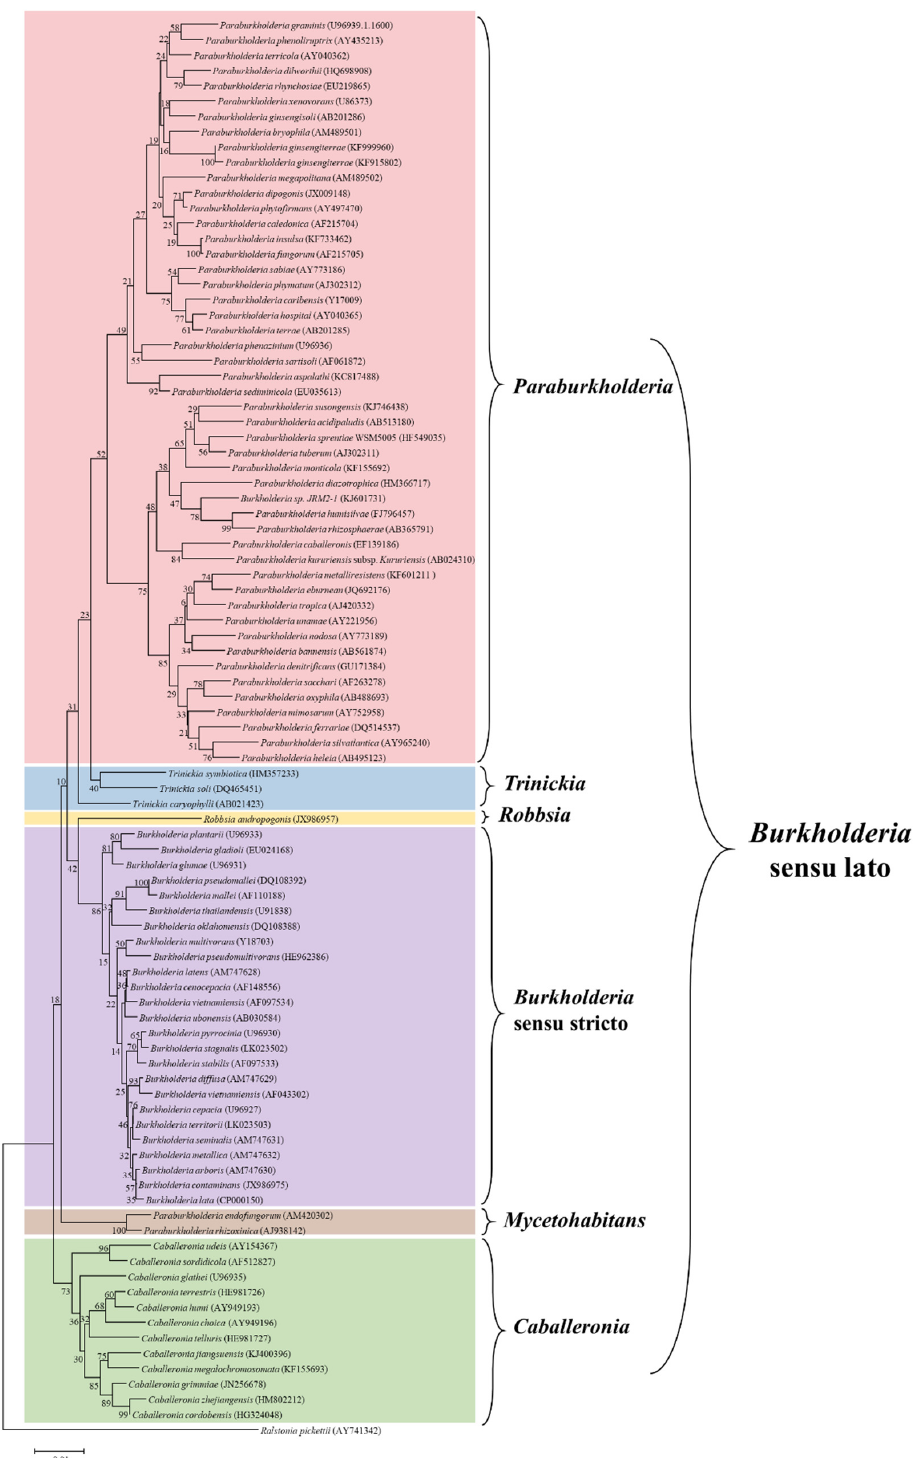
Figure 1. Phylogenetic tree constructed by the neighbor-joining method using 16S rRNA sequences of representative strains of Burkholderia sensu lato assemblage. The 16S rRNA sequences were retrieved from the SILVA database (https://www.arb-silva.de/). Species names were corrected to match the current taxonomic positions and the accession numbers for each sequence are given in parenthesis following the species name. The updated genera and their phylogenetic relationships are also shown. Ralstonia pickettii (AY741342) was used as an outgroup.